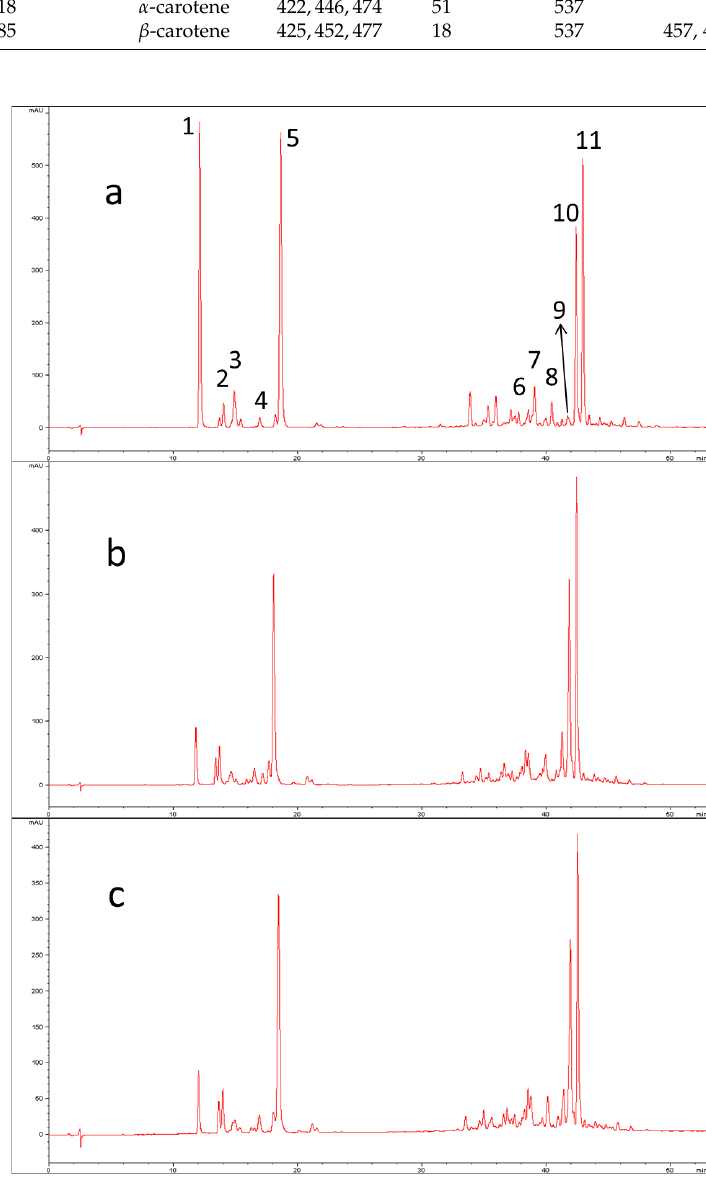
Figure 1. HPLC-UV/Vis chromatograms of “Violina” pumpkin extracts: ( a ) raw fresh sample; ( b ) steam-cooked sample; ( c ) oven-cooked